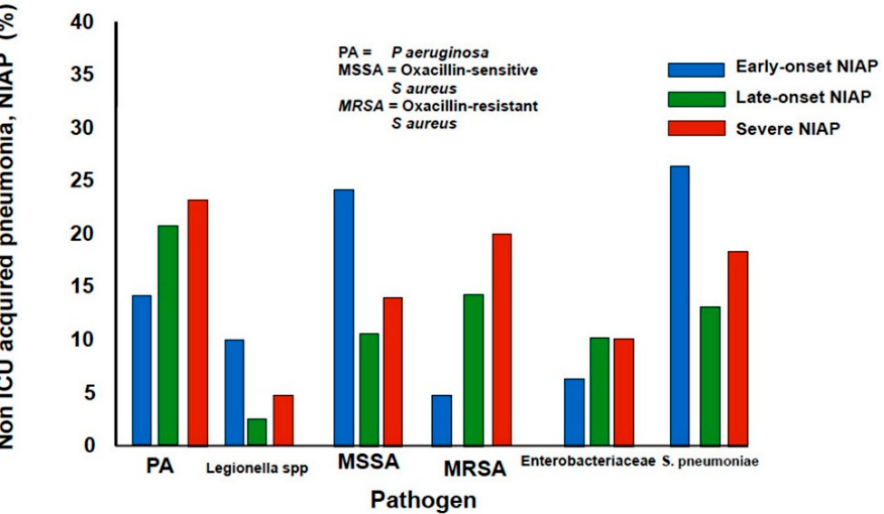
Figure 4. Etiologic pathogens according to categories of non-ICU acquired pneumonia (NIAP).